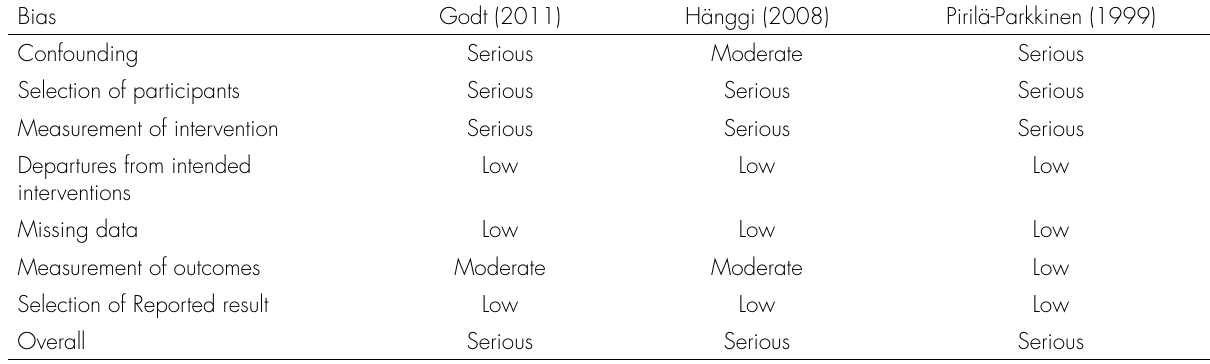
Table II. Risk of bias assessment (ACROBAT-NRSI